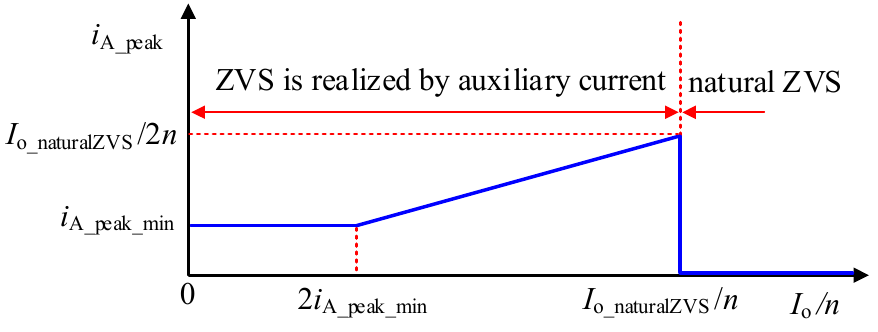
Figure 7. The designed value of i A_peak .